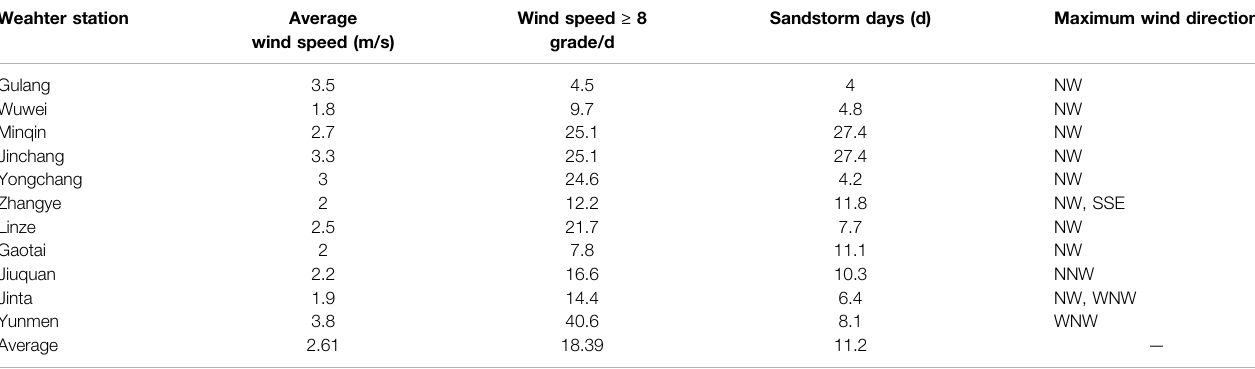
TABLE 5 | Meteorological data of sandstorm and strong wind in the Hexi Corridor (cited from Chang et al. (2015)). Weahter